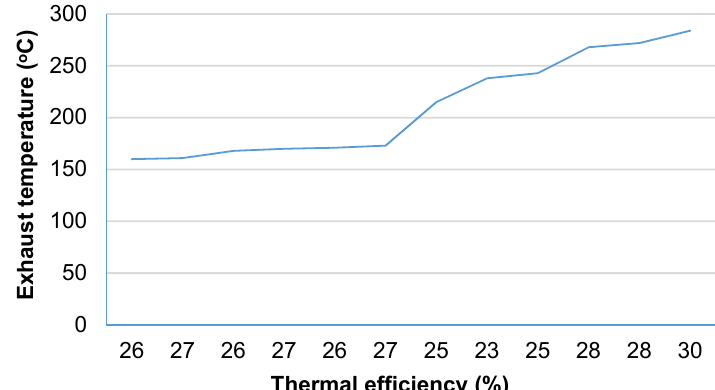
Figure 10. Thermal efficiency of a chimney made of perlite concrete blocks.